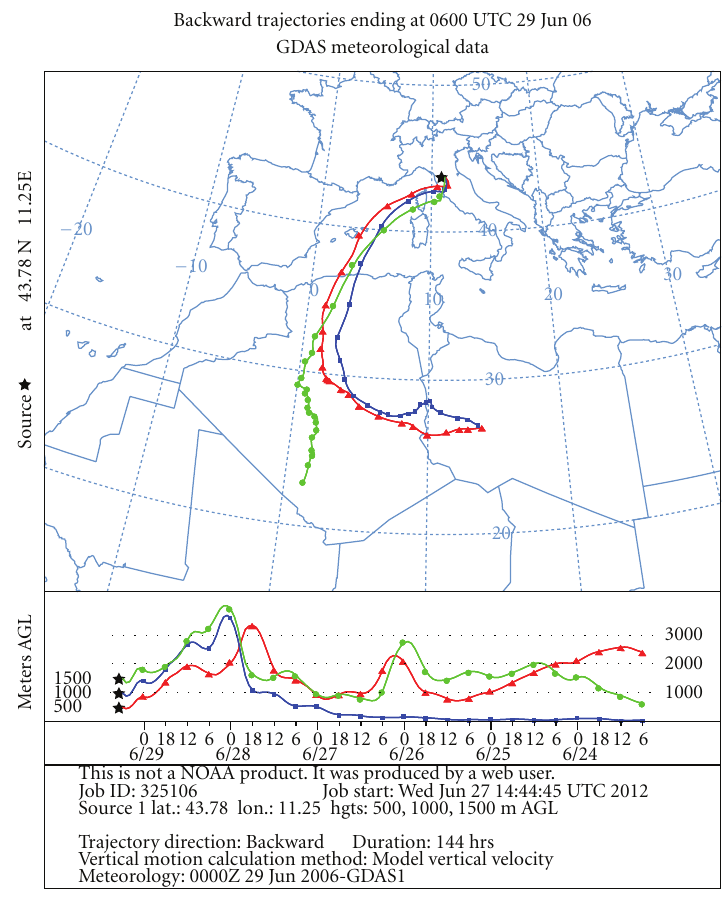
Figure 5: 144 hr back trajectories calculated by the HYSPLIT transport model (NOAA Air Resource Laboratory). The trajectories end in Florence at three di ff erent levels above the ground (10, 100, and 500 m) on the 29th of June 6:00